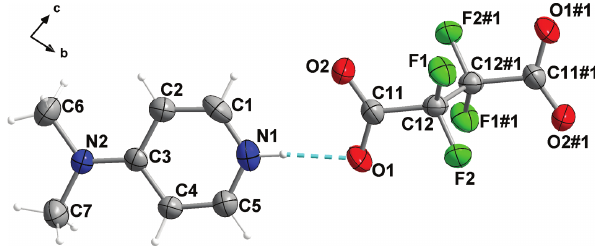
Table 1: Data collection and handling.